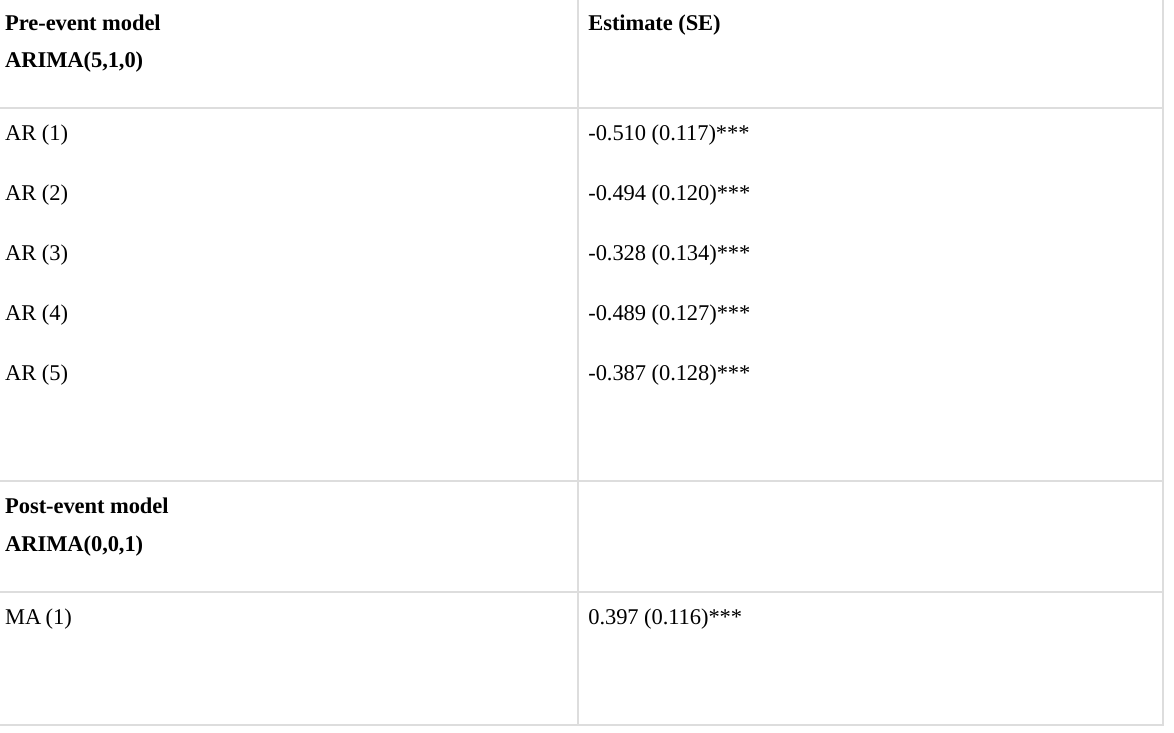
Table A2a. Parameter estimates of ARIMA models for vaccine myths.